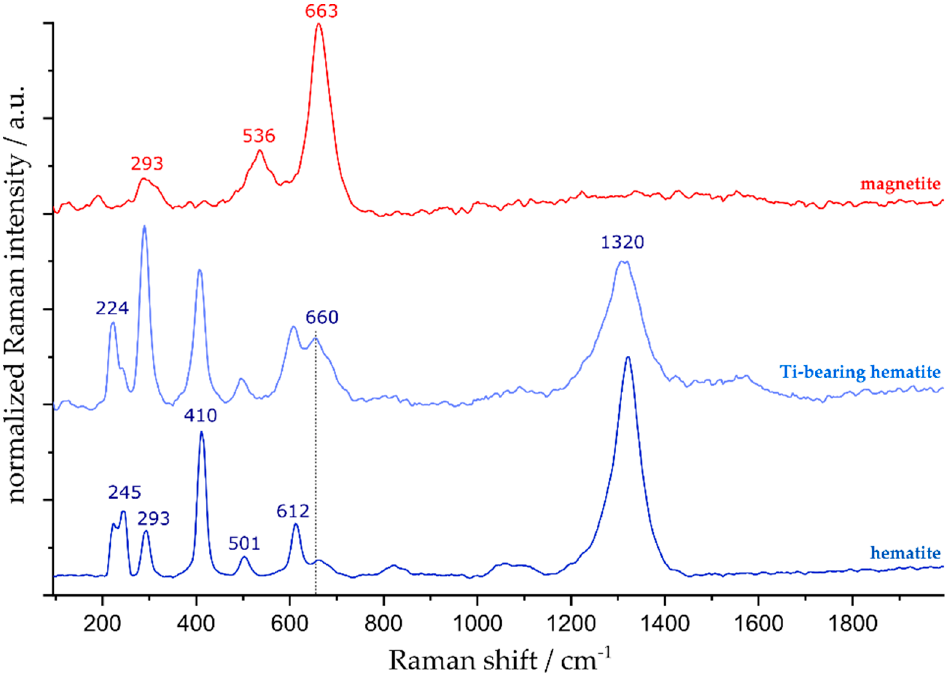
Figure 4. Characteristic Raman spectra of magnetite, hematite, and Ti-bearing hematite. Note that the peak width and intensity for both hematites vary according to elemental changes.